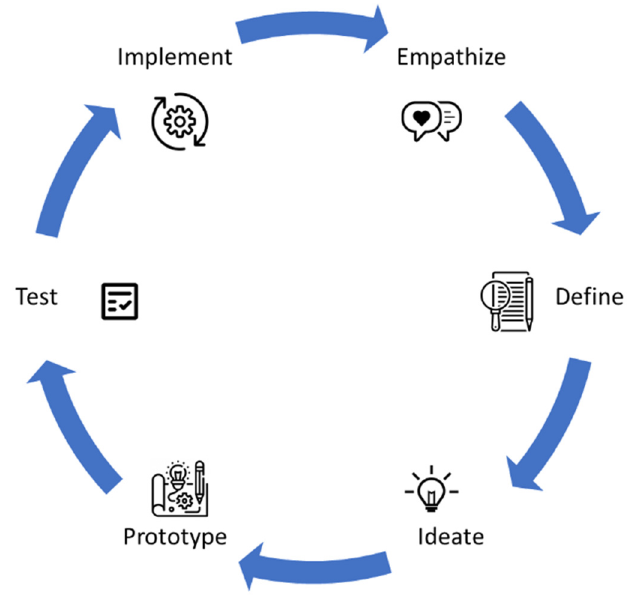
Figure 4. The stages of the design thinking process. Source: image processed after Christian Müller- Roterberg—Design Thinking.